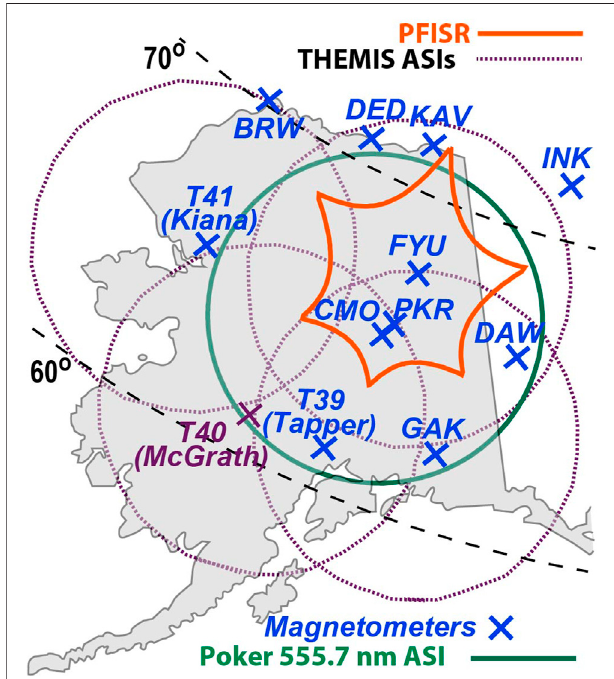
FIGURE 1 | FOVs of the Poker Flat 557.7 nm images, the THEMIS ASIs in the Alaskan sector, and the PFISR radar. Also shown are ground magnetometer locations. These include the THEMIS ASI stations, except that we do not use magnetometer data from T40. IAGA station names are used (see https://supermag.jhuapl.edu/ for station